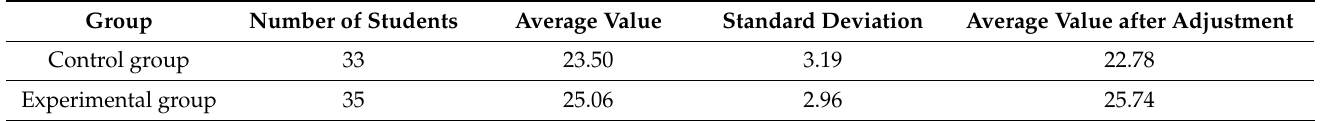
Table 17. Recapitulation sheet of statistics in overall learning effectiveness of basic electricity practical in terms of the skill component.